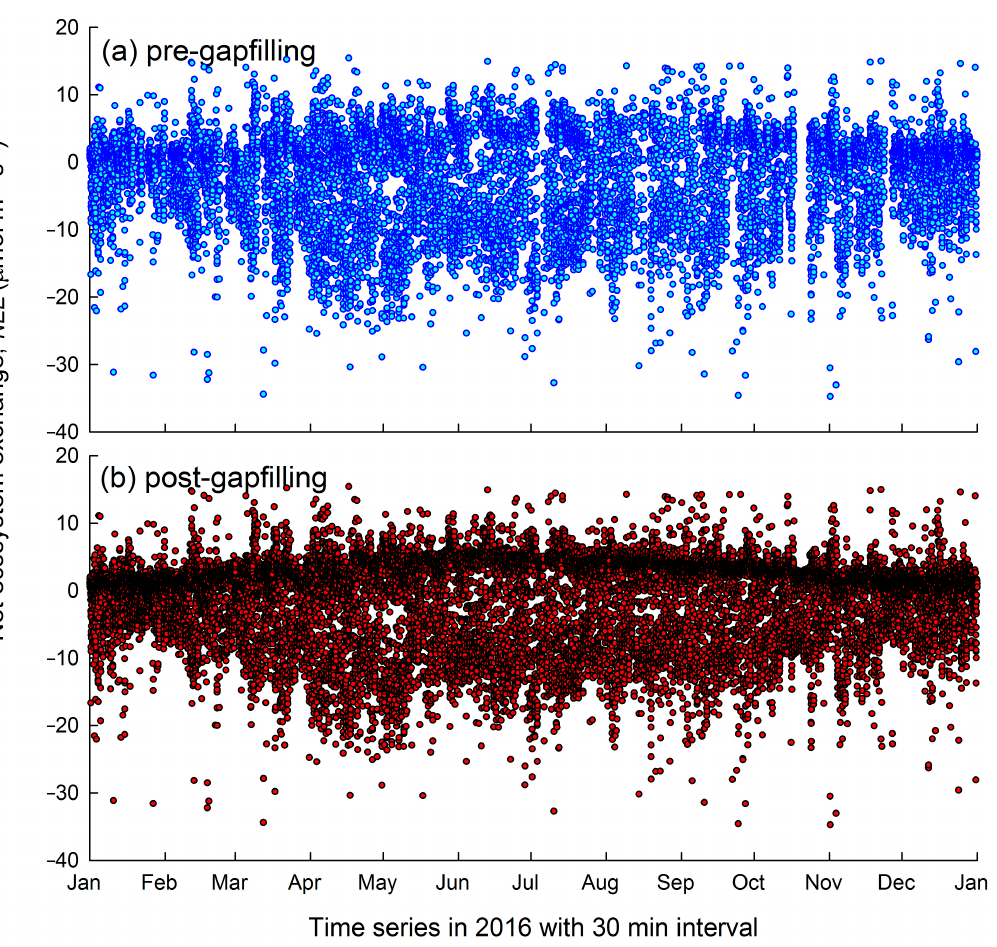
Figure 6. Time series of the net ecosystem exchange before ( a ) and after gap filling ( b ). The figure shows 30 min intervals for one-year data collected in 2016.